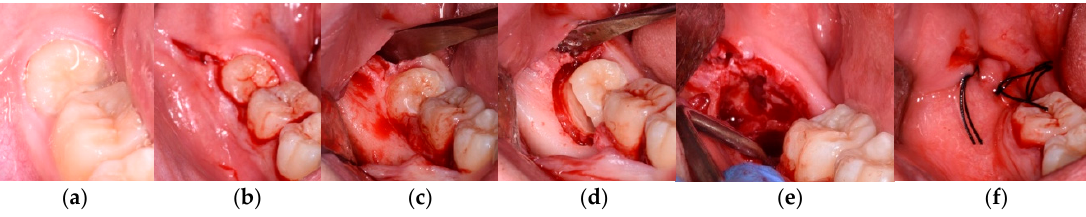
Figure 1. Treatment sequence on control side. ( a ) Baseline. ( b ) Incision. ( c ) Mucoperiosteal release. ( d ) Osteotomy and odontosection. ( e ) Revision. ( f ) Suture.